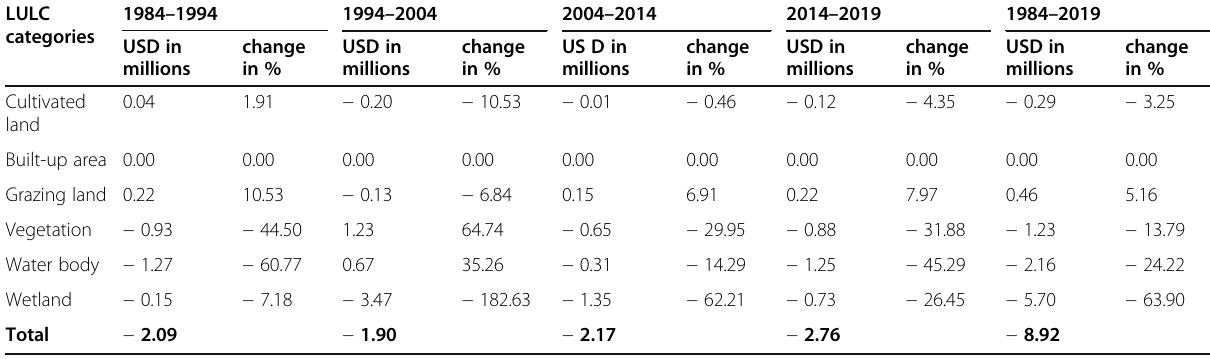
Table 8 Changes in ecosystem service values (ESVin USD ×10 6 ) for each land use/land cover (LULC) category of Bahir Dar City LULC categories Cultivated land Built-up area 0.00 Grazing land 0.22 Vegetation Water body − 1.27 Wetland − 0.15